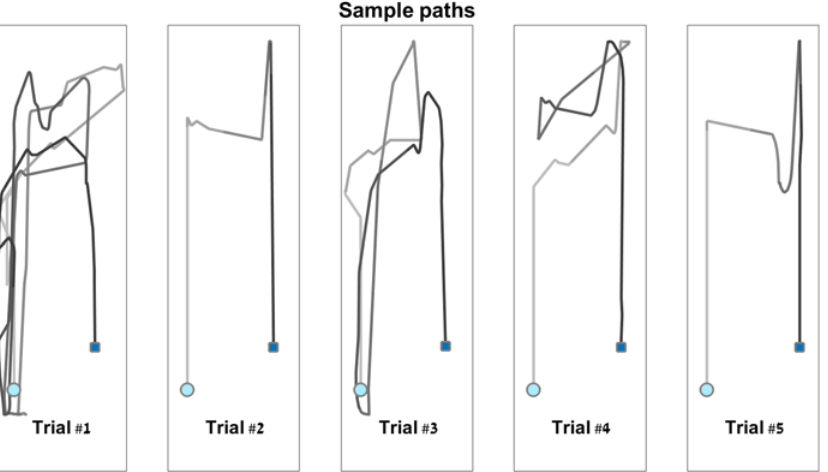
Fig 5. An example of actual paths traversed by the virtual avatar. Shown here are sample paths from a senior participant, completing maze G in the visual, stationary condition. Showing trials 1 – 5 for this maze, from left to right. A light blue circle denotes the starting point, and a dark blue square denotes the end point.